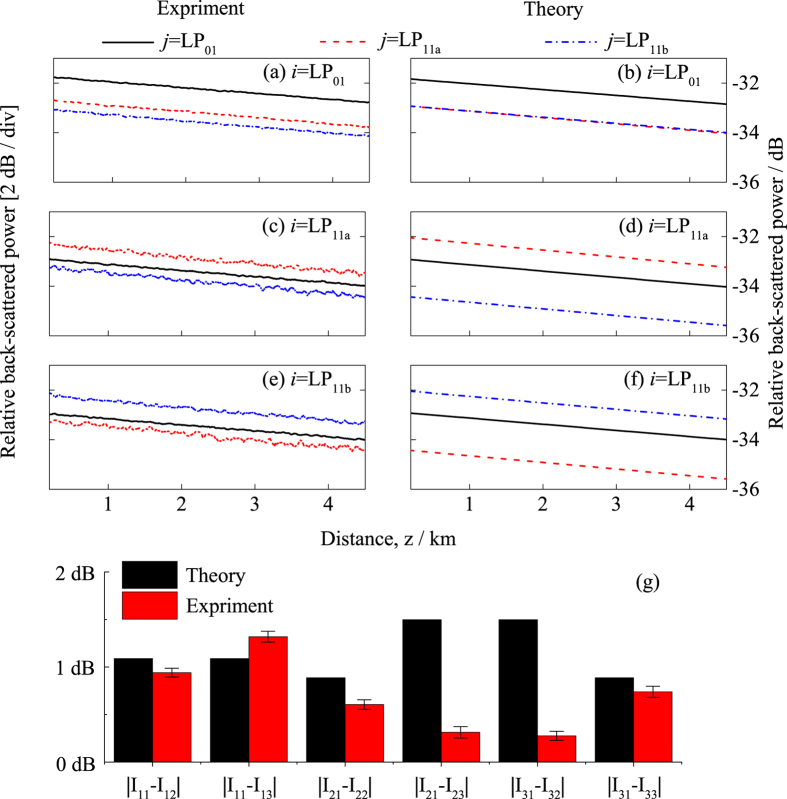
Optical-time-domain-reflectometer measurement of Rayleigh back-scattering in a three-mode optical fiber and the corresponding theoretical results.(a) experimental results with LP01 excitation; (b) theoretical results with LP01 excitation; (c) experimental results with LP11a excitation; (d) theoretical results with LP11a excitation; (e) experimental results with LP11b excitation; (f) theoretical results with LP11b excitation; (g) comparison of the experimental and theoretical intercepts relative to Ii1.